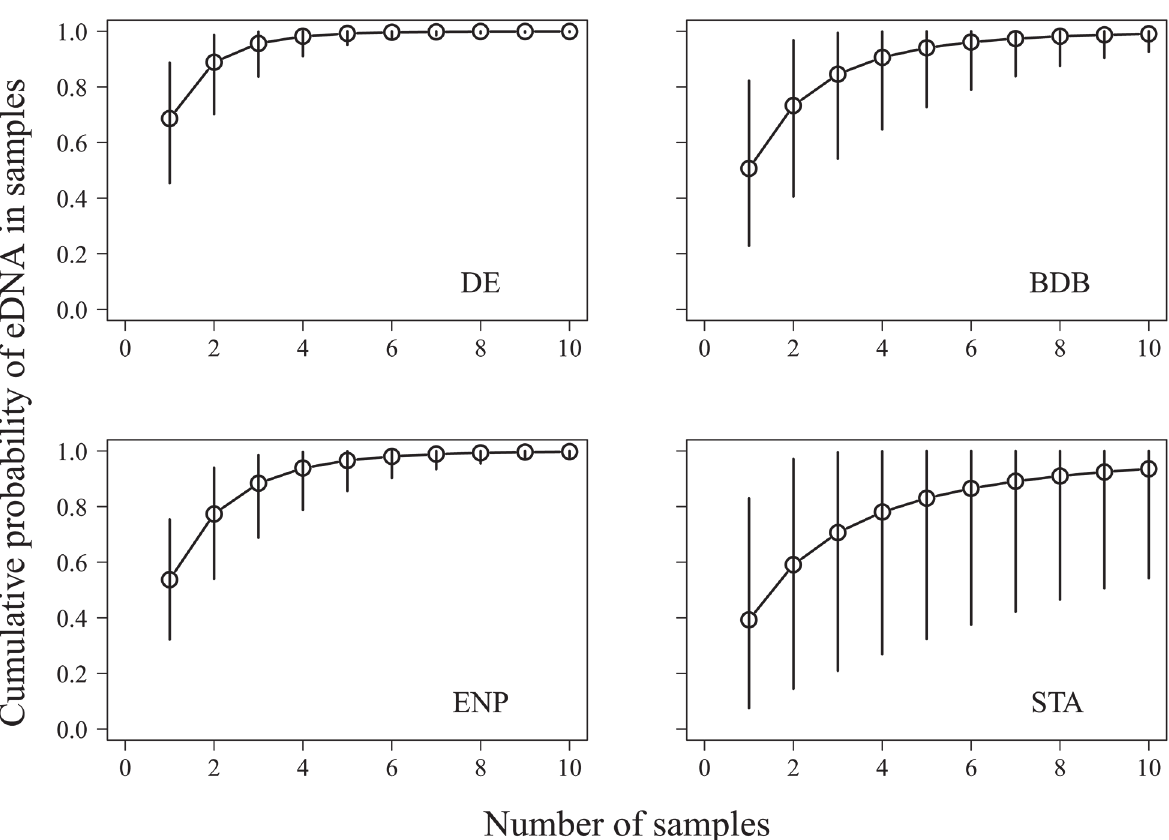
Fig 3. The effect of sample size on estimates of the cumulative probability of occurrence of Burmese python environmental DNA ( θ * ) associated with samples taken from the four field locations analyzed by the three-level occupancy model. BDB, Bird Drive Basin; DE, Deering Estates; ENP, Everglades National Park; STA, Stormwater Treatment Area